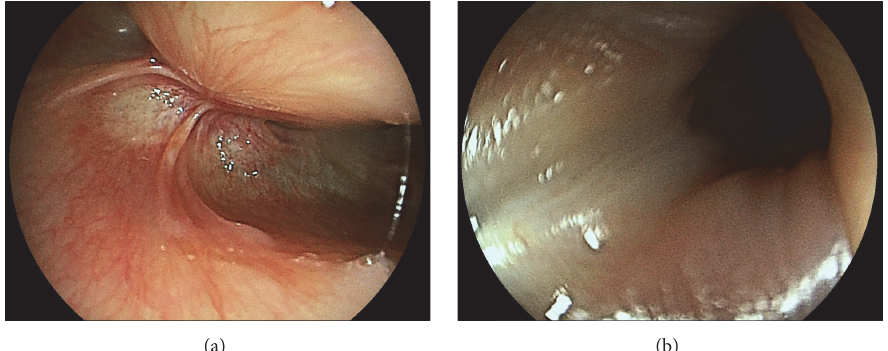
Figure 7: (a) At 8 months after treatment, no local recurrence was observed. (b) No stricture was observed at the cervical esophagus.